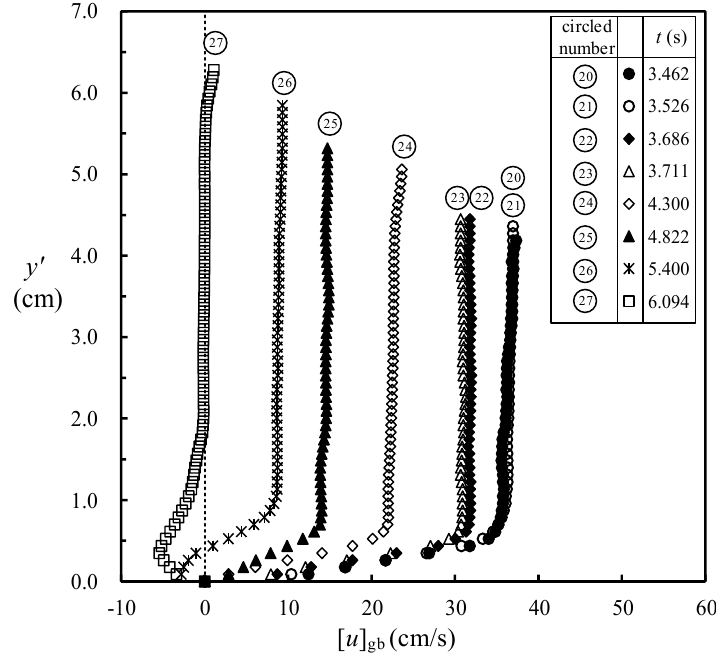
Figure 11. Temporal variation of horizontal velocity profile of generated bore obtained at SMS for 3.462 s ≤ t ≤ 6.094 s during run-up motion (as labeled from circled 20 to 27 in Figure 7a,b).